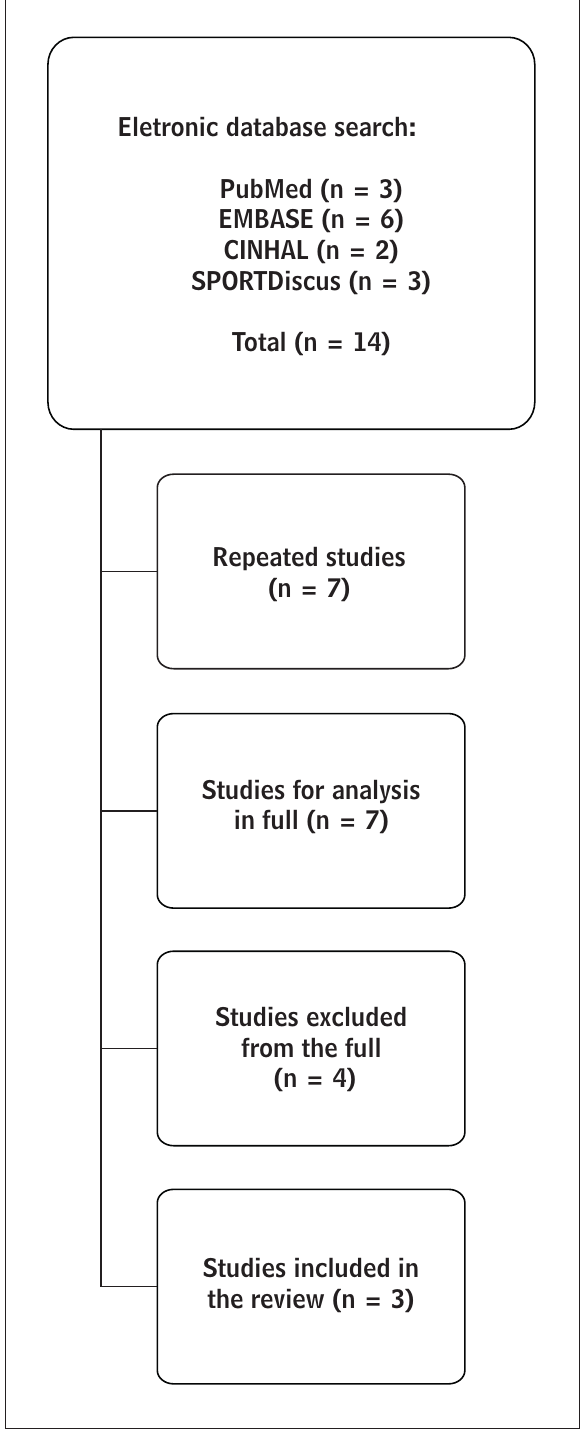
Figure 1 - Flow chart of the selection of the